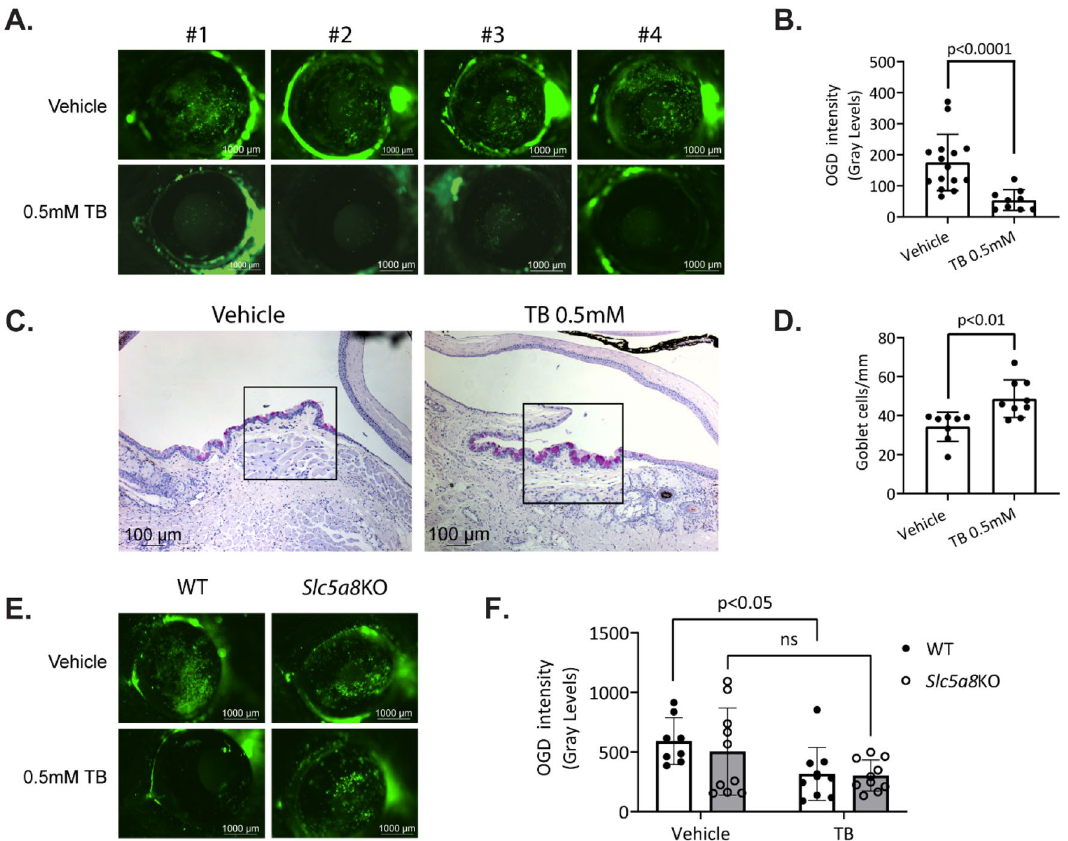
Figure 3. Administration of tributyrin (TB) to mice undergoing desiccating stress protects against corneal barrier disruption and loss of conjunctival goblet cells. ( A ) Representative images of corneal permeability to Oregon-green-dextran (OGD) of four different animals from each treatment group. ( B ) Corneal epithelium permeability to OGD was quantified by measuring the mean fluorescence intensity. Each data point represents the average value from both eyes of one animal, n = 8–15 animals. ( C ) Representative images of conjunctival cryosections with PAS-stained goblet cells (purple-magenta) from TB and vehicle control-treated (PBS) mice. Area demarcated by the square is high magnification of the area underneath. ( D ) Accumulative data for conjunctival goblet cell number per mm, n = 8–9. ( E ) Representative images of corneal permeability to Oregon- green-dextran (OGD) of animals from each treatment group. ( F ) Corneal epithelium permeability to OGD for wild-type (WT) and Slc5a8 knockout (KO) mice gavaged with either vehicle control or tributyrin. Statistical comparisons were made using two-way ANOVA using Tukey’s multiple comparisons test. P value greater than 0.05 was considered non-significant